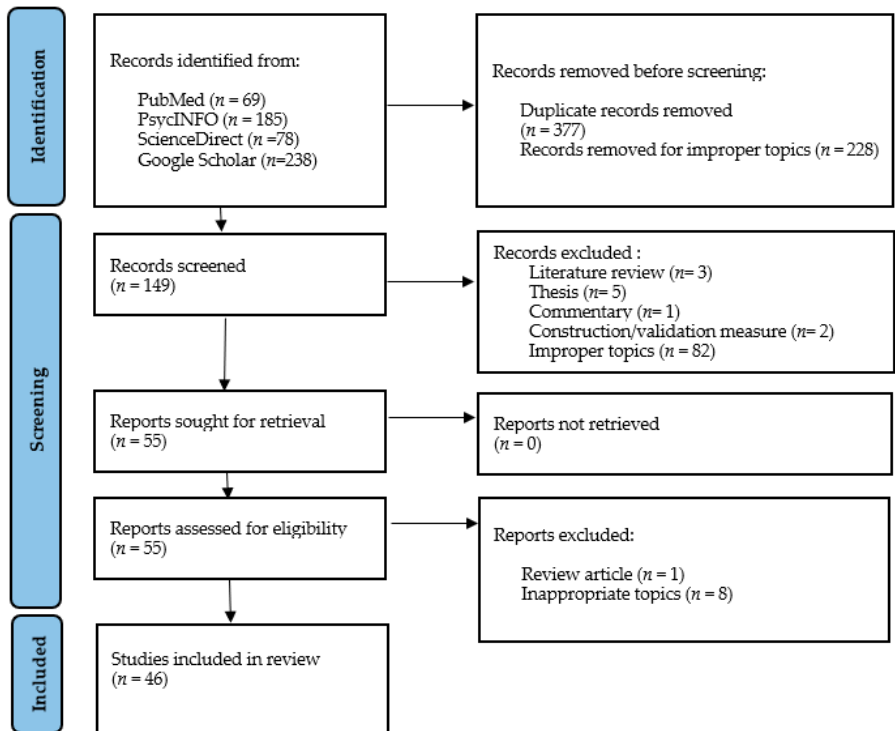
Figure 1. Flowchart of the inclusion procedure for the review.